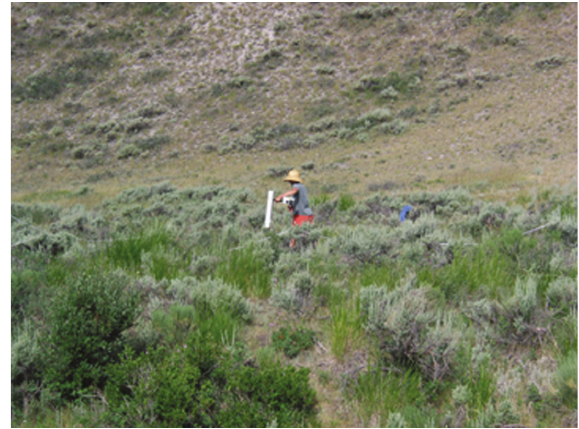
Figure 3: Using the handheld gradiometer in the field introduces a wide range of nonlinearity. Flora, terrain, and user inconsistencies all add to uncertainty inherent in the